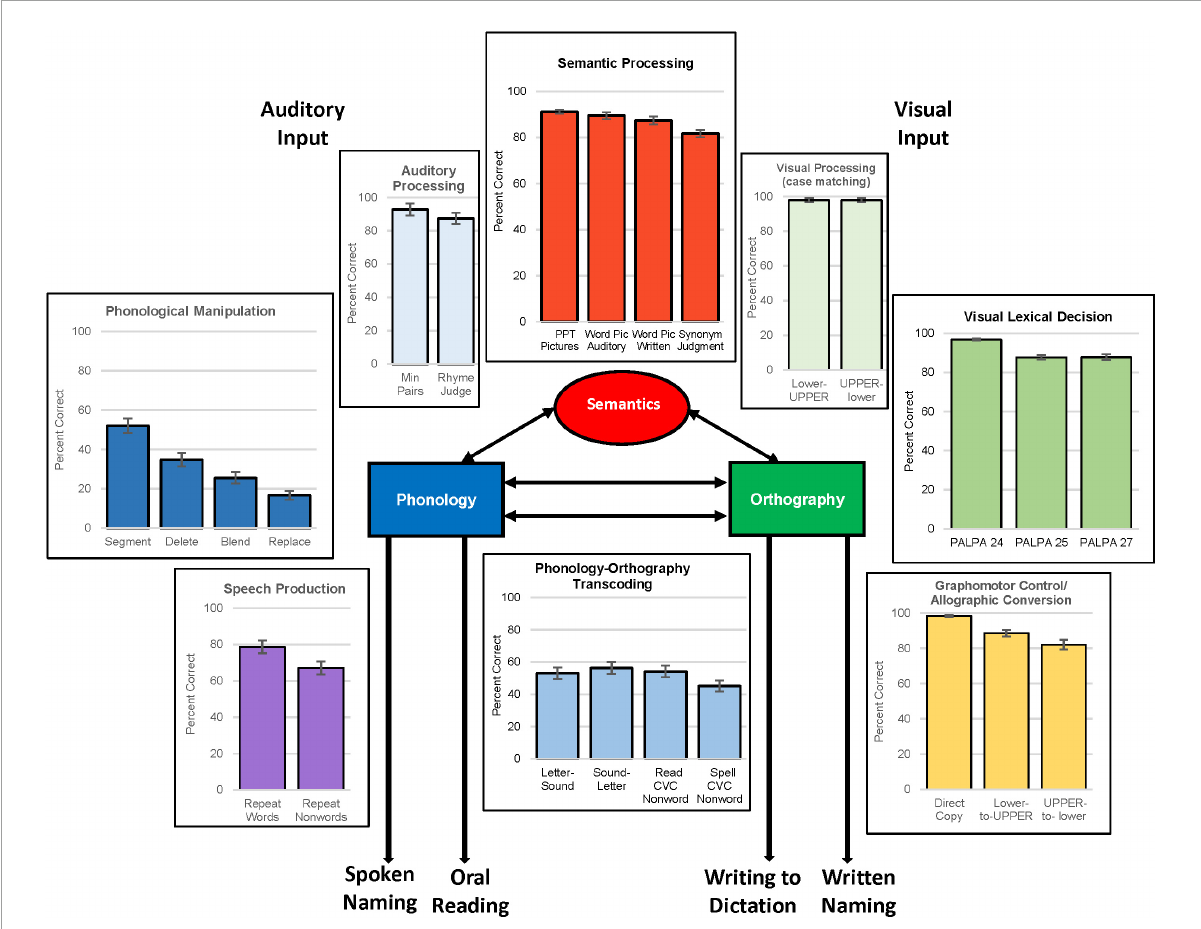
FIGURE2 Schematic model of cognitive processes supporting spoken and written language processing with performance on representative tasks by language-impaired cohort.